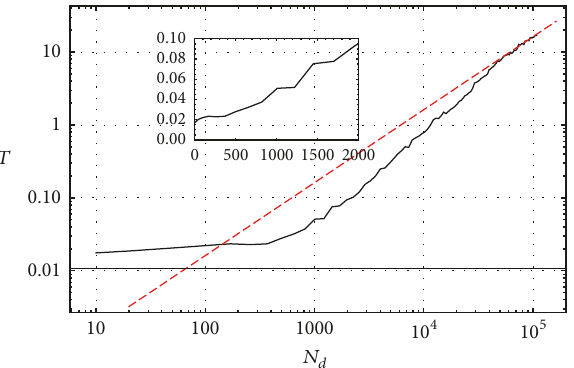
Figure 6: CPU time versus the number of digits for the power series solution of NLSE, (29). Parameters used: 𝑁 max = 4 , 𝑁 = 400 , 𝑓(0) = 1 , 𝑓 󸀠 (0) = 0 , and Δ = 1/𝑁 . Inset shows a zoom on linear scale. Red dashed line is an asymptote of slope equal